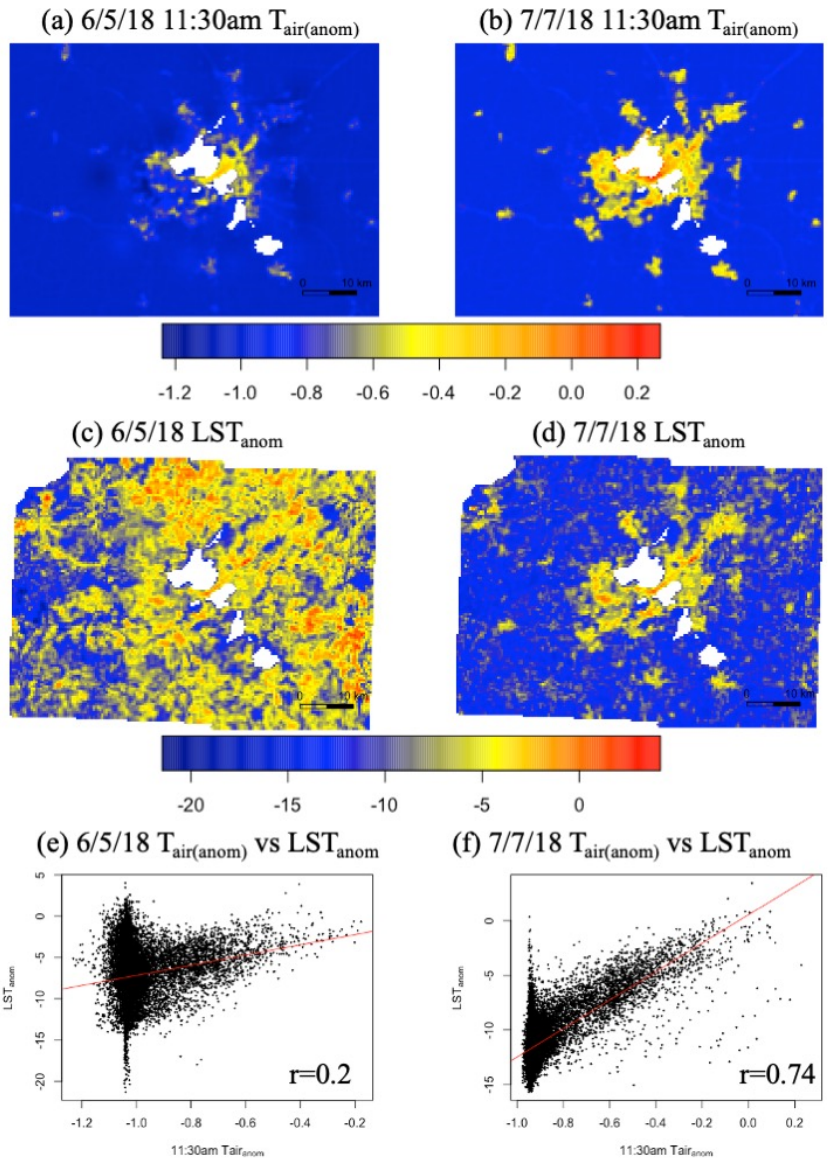
Figure 4. ( a , b ) T air(anom) and ( c , d ) LST anom for two different dates during summer 2018. ( e , f ) show scatterplots of T air(anom) plotted against LST anom . All panels in the left column display data from 5 June 2018 and panels in the right column displays data from 7 July 2018. Temperatures of the lakes (in white) are masked out from ( a ) through ( d ).